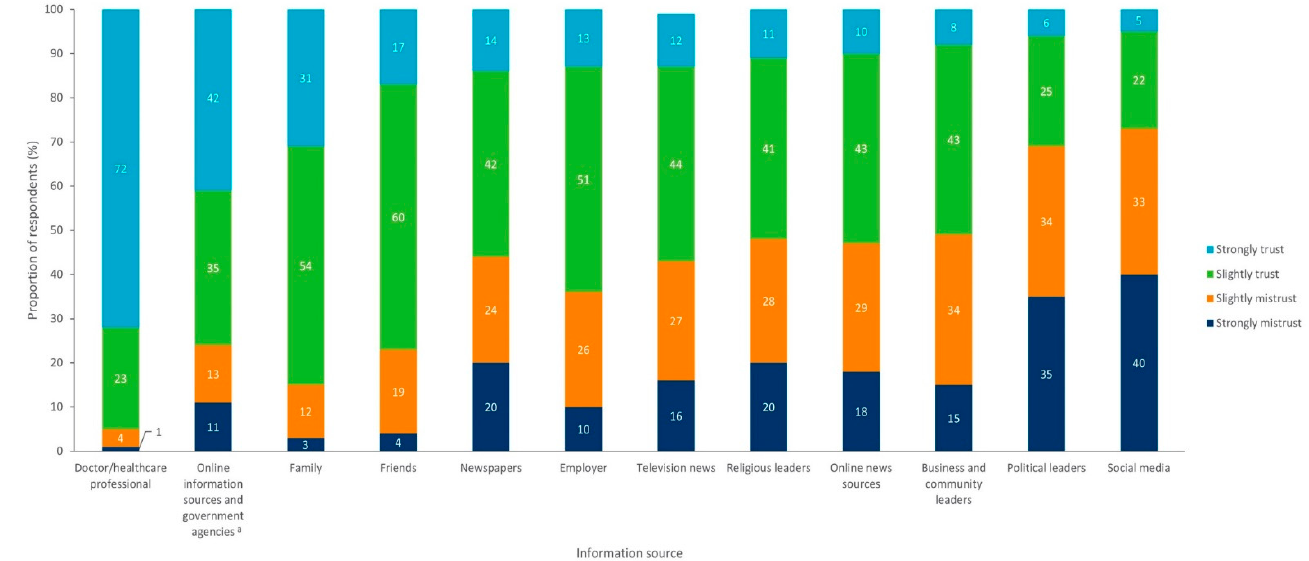
Figure 6. Level of trust in vaccine information sources for all respondents (n = 5000). a For example, the Centers for Disease Control and Prevention (CDC).